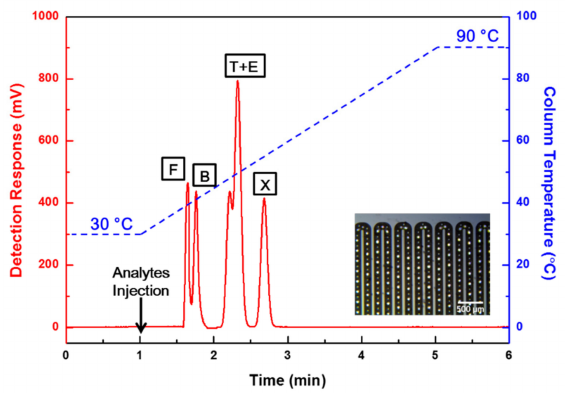
Figure 6. Chromatograms showing the separation results obtained through the post structure µ -GC column for the FBTEX mixture gas. The temperature of the µ -GC column was maintained at 30 ◦ C for 1 min, ramped to 90 ◦ C at a ramping rate of 15 ◦ C / min, and then maintained at 90 ◦ C for 1 min. The temperature programming of the column was performed by micro-heaters and an RTS of the µ -GC column. In the test, all five peaks were detected but two overlapped peaks appeared.